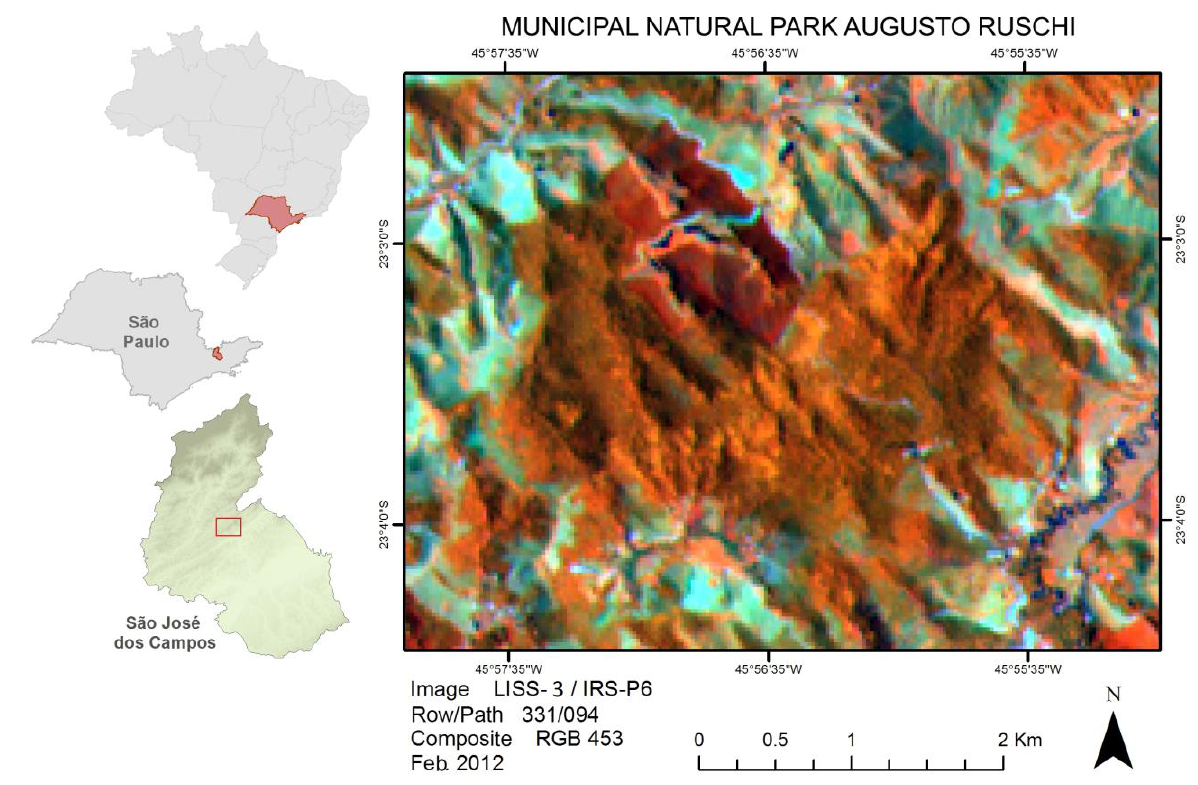
Figure 1. Study area location in a regional context and a Resourcesat/ Linear Imaging Self-Scanner sensor (LISS-3) image showing the forest fragment (in reddish